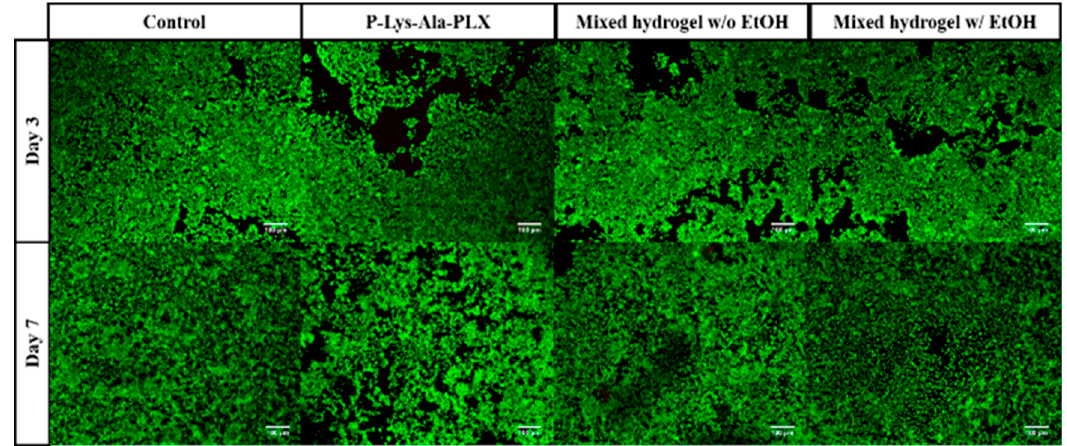
Figure 8. The LIVE/DEAD staining of 293T cells was co-cultured with various hydrogels without the